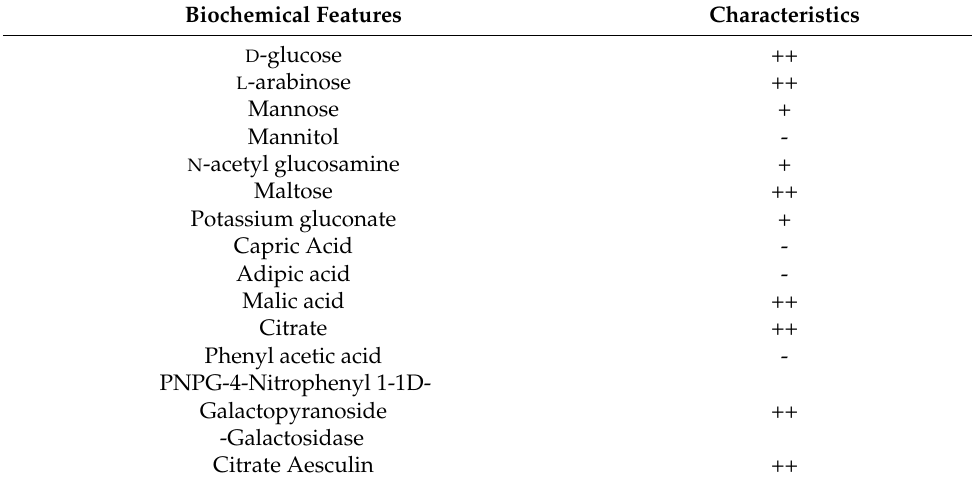
Table 1. Biochemical characteristics of Sphingobium yanoikuyae S72. Biochemical Features